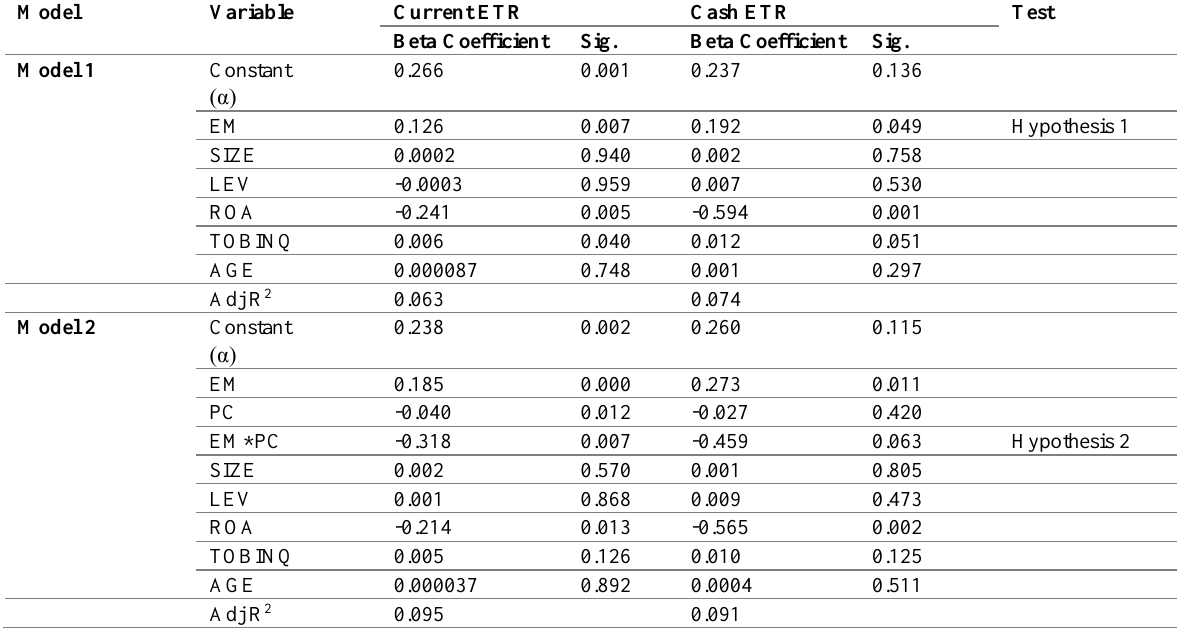
Table 2: Results of Regression